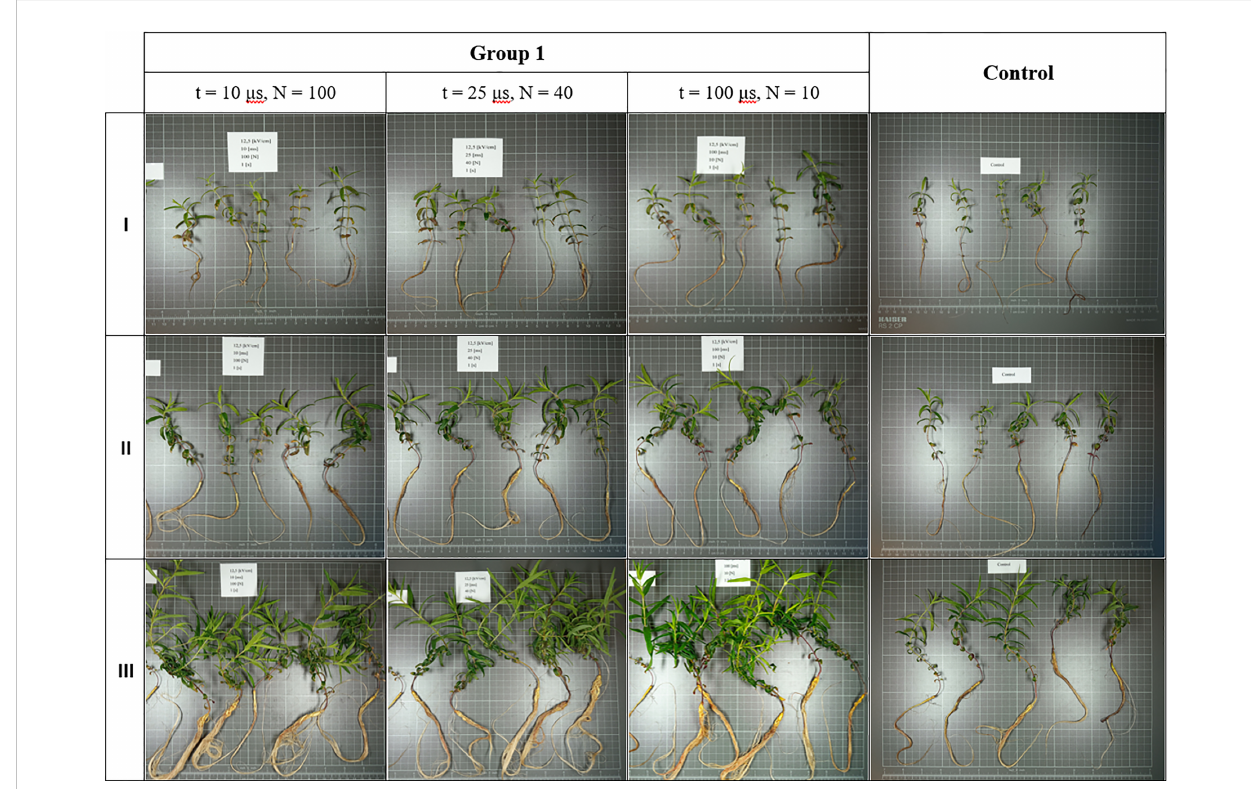
FIGURE 3 Growth and development of S. baicalensis in two-week intervals shown on a 1cm x 1cm grid (row I – two weeks after treatment, row II – four weeks after, row III – six weeks